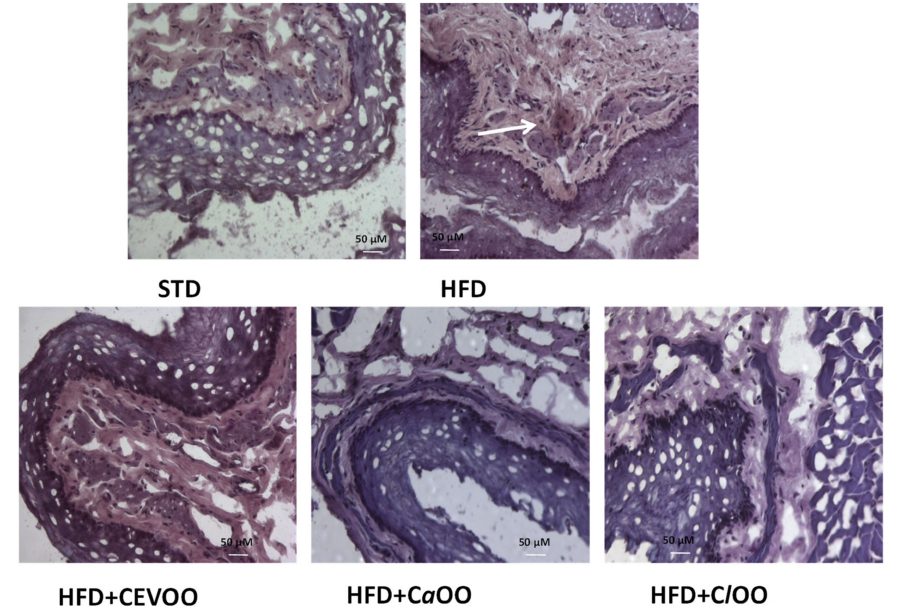
Figure 12. E ff ect of CEVOO, Ca OO and Cl OO supplementation on aortic vascular wall inflammation in HFD fed rats. Immunohistochemical evaluation of snap frozen sections from rat aortic tissues from STD, HFD, HFD + CEVOO, HFD + Ca OO and HFD + Cl OO. Arrow in HFD panel shows staining for CD40. One representative section is shown of three rats / experimental group. Scale bar 50 µ M, original magnification ×